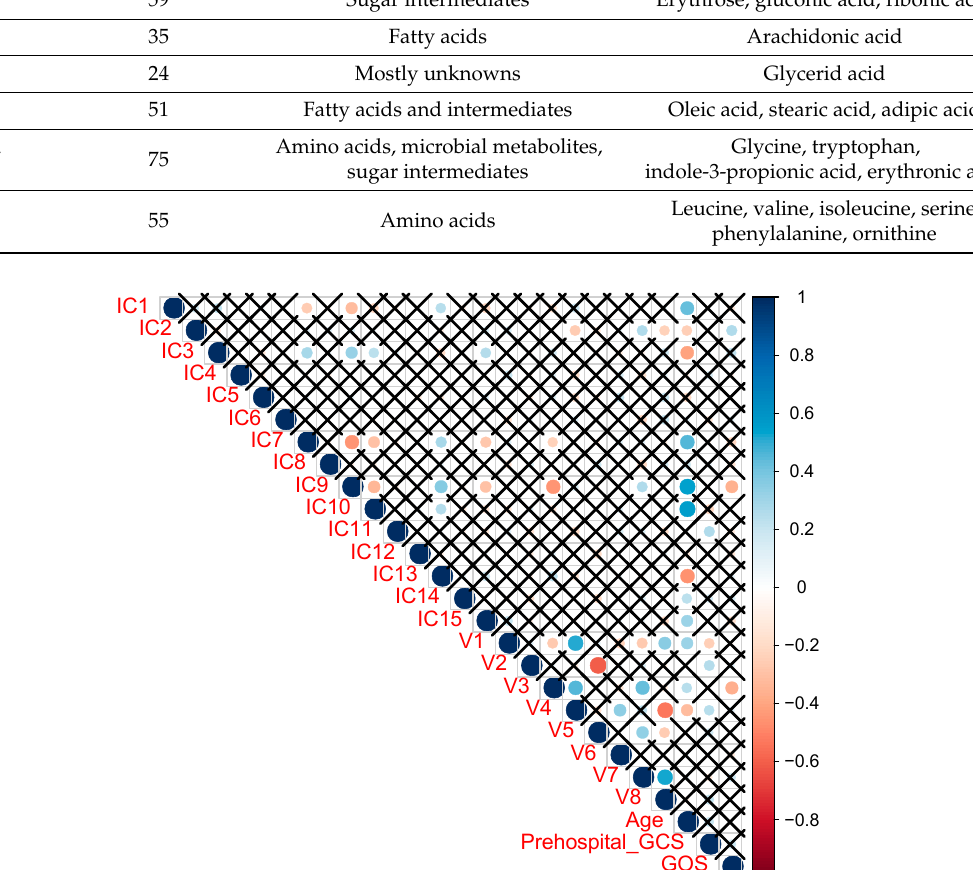
Figure 2. Partial correlations of independent components (ICs) derived from sMRI data with the eight metabolite clusters (Vs), as well as age, GCS, and GOS. Partial correlations among all pairs are shown on that matrix, and when a pair is shown as X, the correlation is not significant ( p -value > 0.05). For the pairs with significant correlations, a bullet is plotted, with its size, transparency and color corresponding to the correlation value (blue signifies positive correlation, red negative).